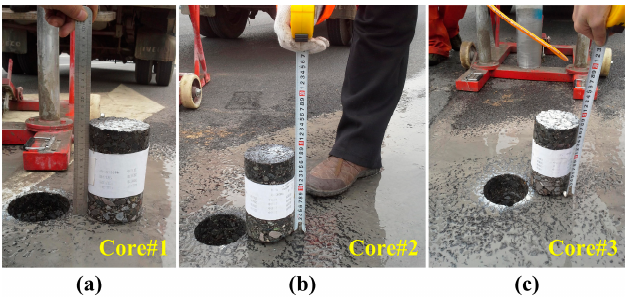
Figure 17. The estimated errors of each pavement segments.